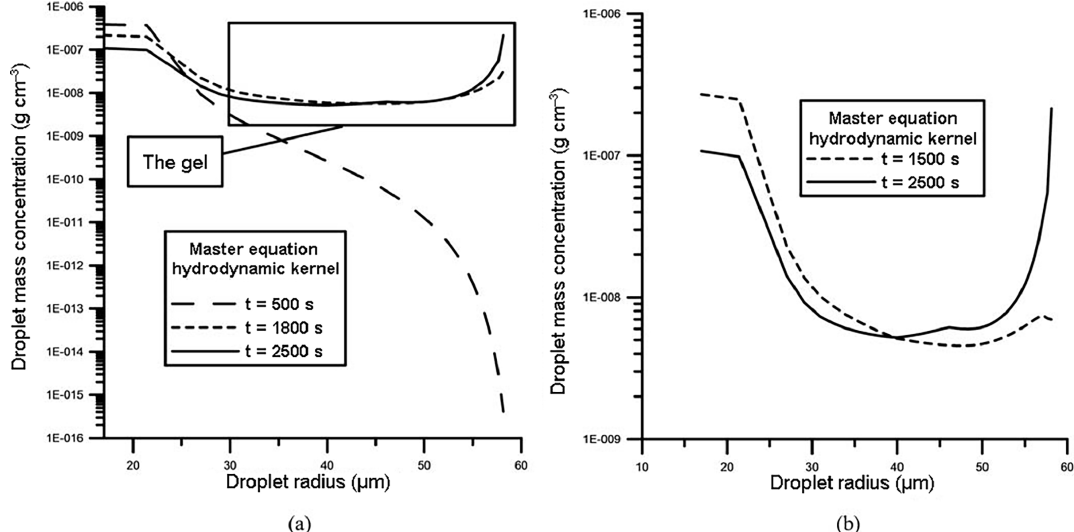
Figure 8. The droplet mass spectrum at different times ( t = 500, 1500, 1800 and 2500s) for a finite system modeled with the hydrodynamic collection kernel. The initial distribution is bidisperse with 20 droplets of 17µm in radius and 10 droplets of 21.4µm in a volume of 1cm 3 .